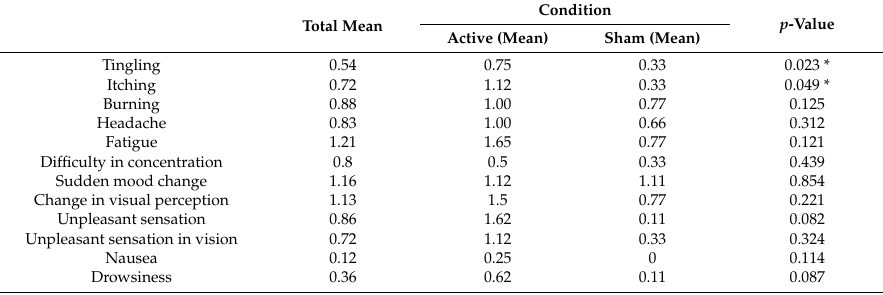
Table 2. Comparing the severity (out of 5) of side effects between active and sham groups for the cerebellum.